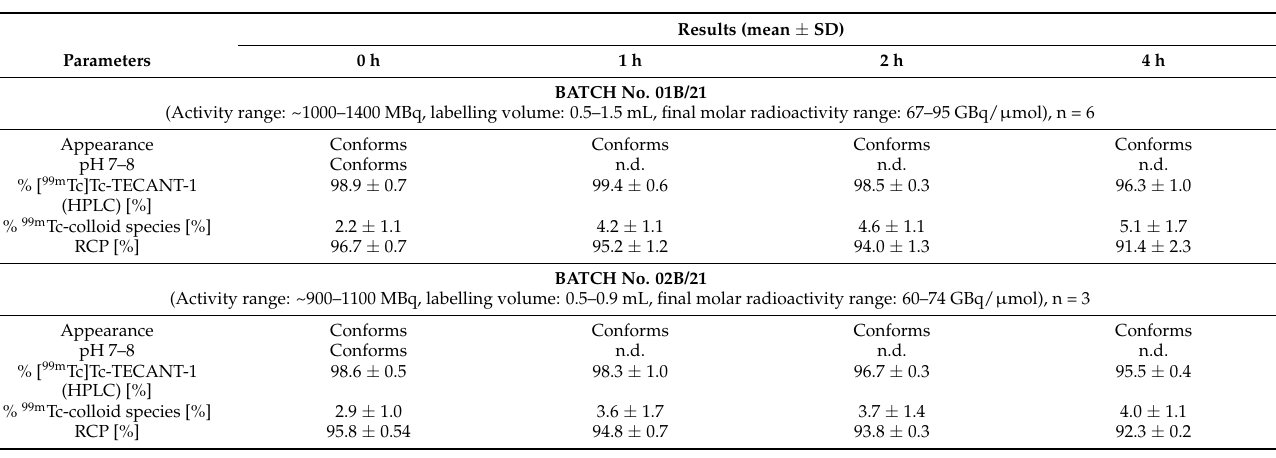
Table 8. Summary of the stability study of the radiolabelled compound prepared from batches 01B/21 and 02B/21. Results (mean ±